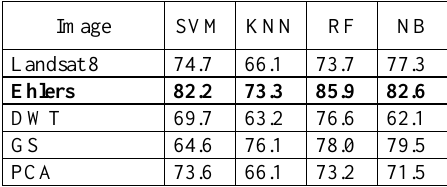
Figure 8. Regular grid of 1x1km showing the SID, ranging from red (low) to green (high). Diversity decreases on the scene borders and in proximity to settlements.